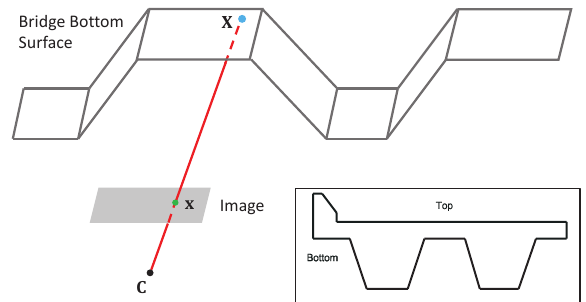
Figure 2: A back-projection illustration with the collinear principle of the camera optical center C , a 2D image point x and its corresponding 3D point X : the 3D structure and the profile map (Bottom-Right) of the bottom surface of a bridge whose structure named “small box girder”.